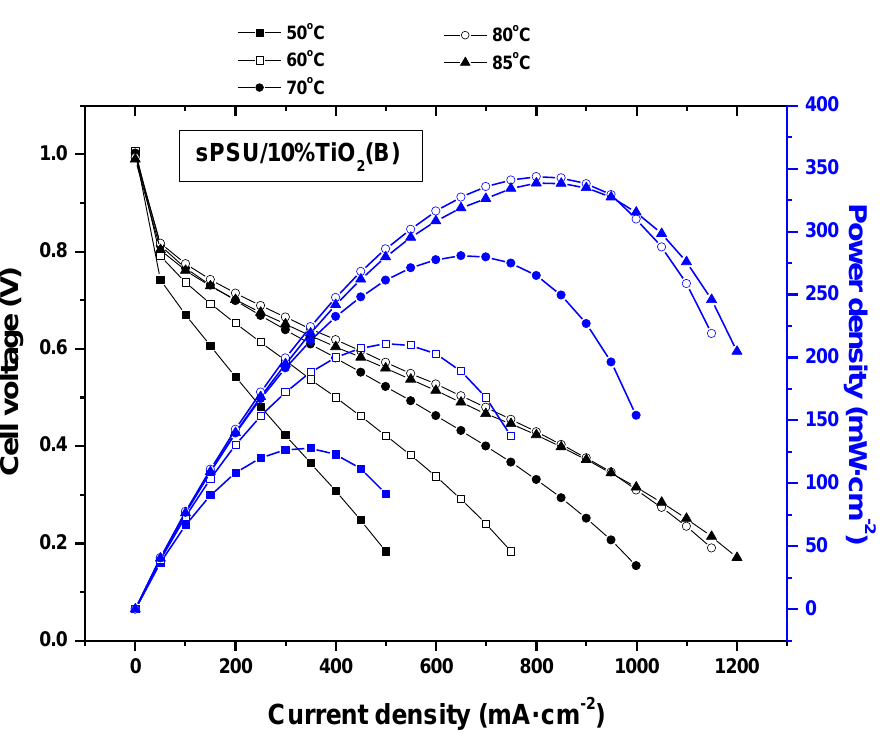
Figure 11. Polarization and power density curves of sPSU/10%TiO 2 (B) composite membranes registered in the 50–85 °C temperature range.